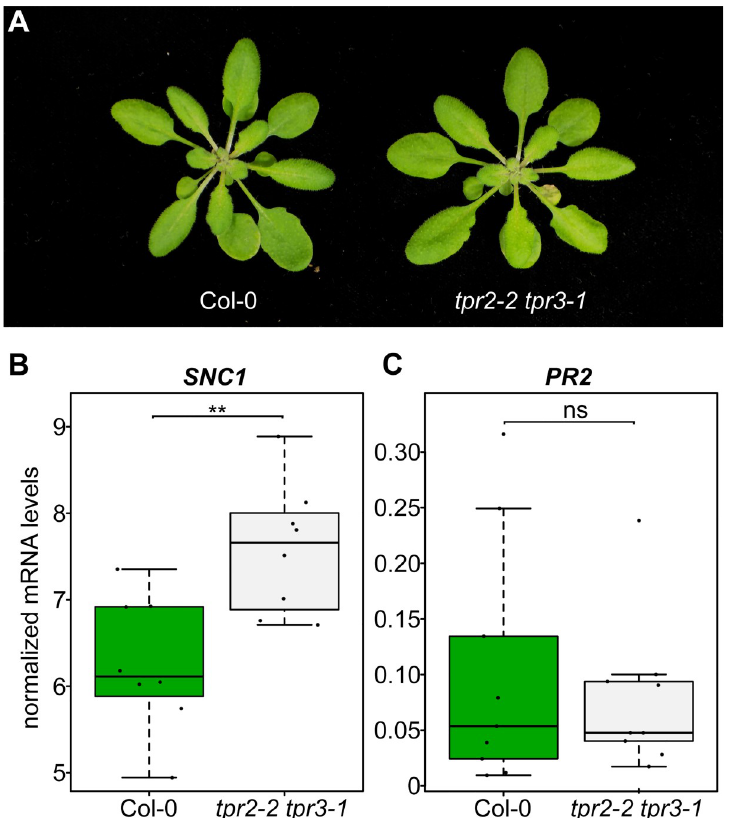
Fig 4. SNC1 expression is increased in tpr2 tpr3 . (A) Morphological phenotype of tpr2-2 tpr3-1 . Plants were grown for four weeks under short day conditions at 21˚C. (B&C) Expression as measured by quantitative RT-PCR of PR2 and SNC1 . Dots represent individual data points taken over two separate experiments. Genes of interest were normalized against SAND (At2g28390). Whiskers on boxplots are drawn to the farthest data point within 1.5 � IQR of first and third quartiles. Asterisks denote significant differences as determined by Student’s t-test ( P < 0.005) using the Bonferroni-Holm method to correct for multiple comparisons.